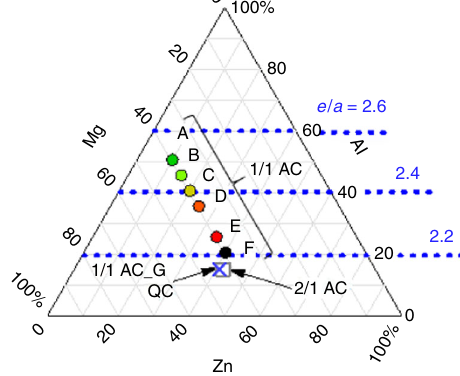
Fig. 2 Ternary phase diagram. The samples studied here are summarized in the ternary phase diagram. The 1/1AC samples have a wide composition range: Each 1/1AC sample with different composition is identi fi ed using the alphabetical character. The composition of both the QC and the 1/1AC_G (the mother alloy of the QC) is Al 14.9 Mg 44.1 Zn 41.0 , and that of the 2/1AC